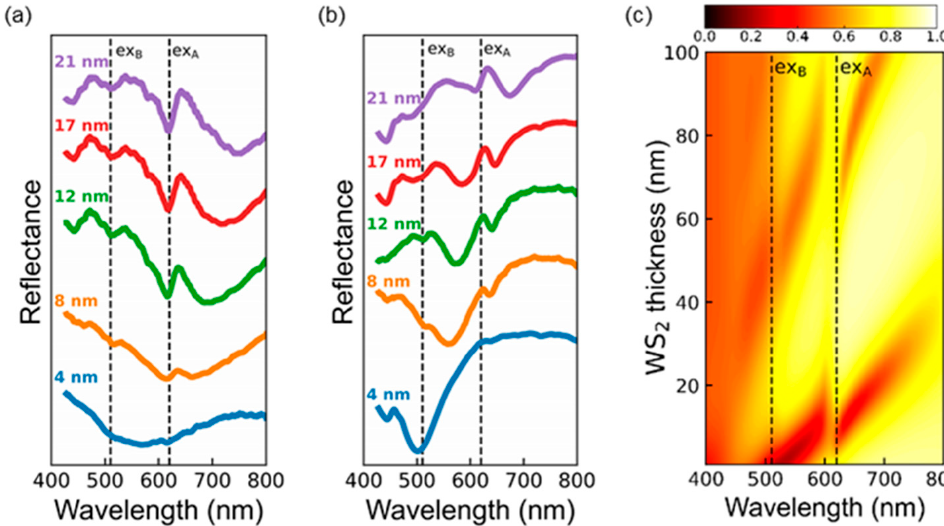
Figure 6. Measured optical reflectance spectra of WS 2 flakes on SiO 2 /Si ( a ) before and ( b ) after deposition of 30-nm-thick Au thin films. ( c ) TMM-calculated reflectance spectra of Au(30 nm)-coated WS 2 flakes on SiO 2 /Si. The exciton resonance (ex A and ex B ) wavelengths of WS 2 are denoted as dashed lines in ( a – c ).